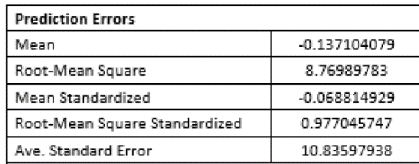
Table 5: Values of the Prediction Errors of the Best Surface for Turbidity